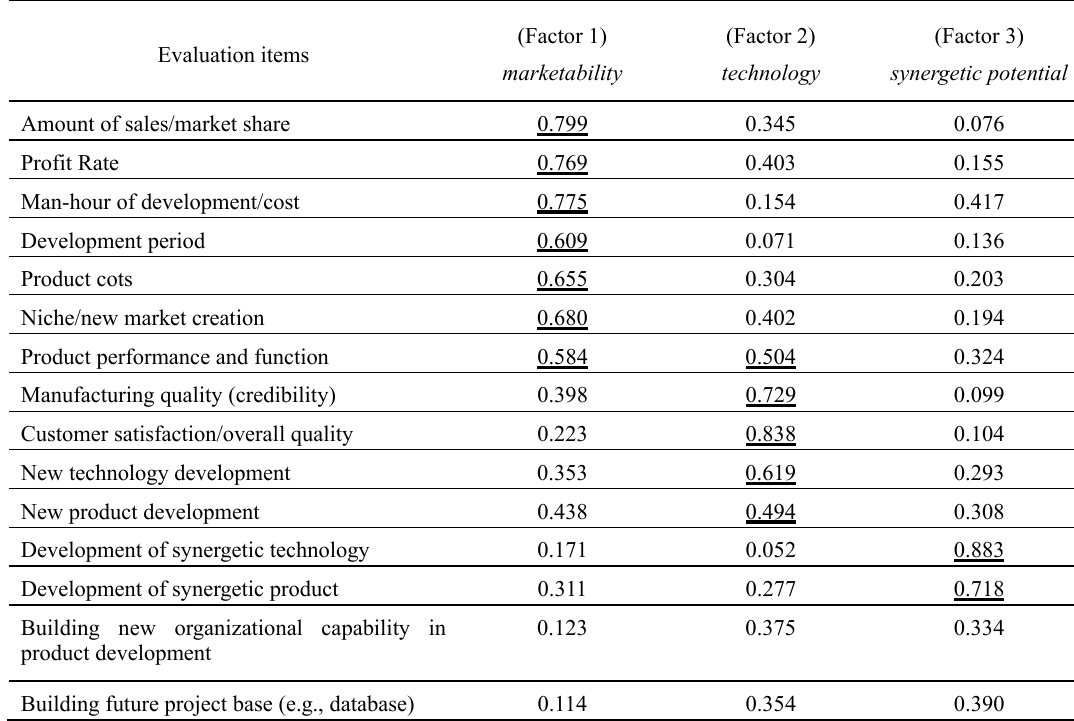
Table 2. Factor Analysis on Evaluation